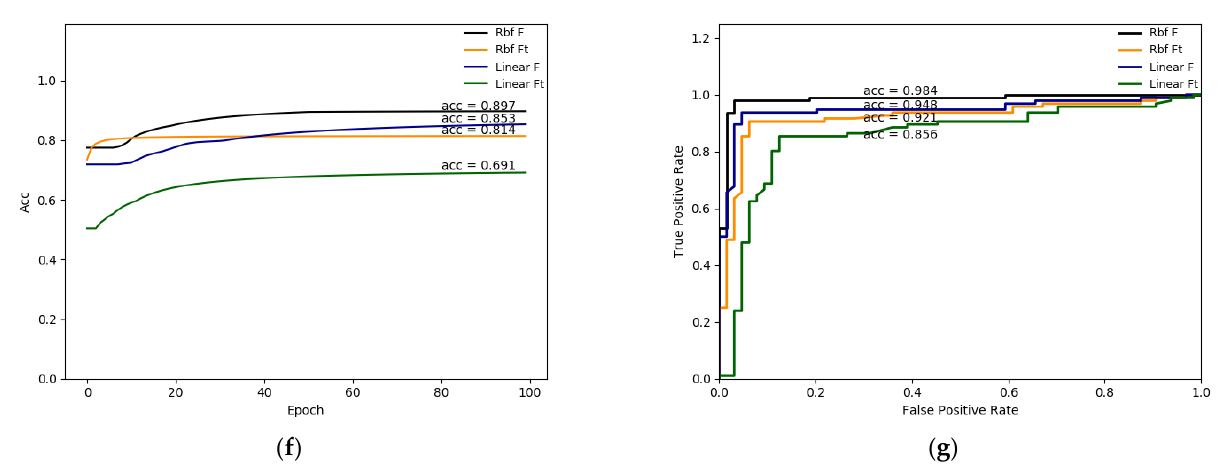
Figure 7. The principle of feature extraction and classification: ( a ) the normal pulse and its wavelet component; ( b ) the slippery pulse and its wavelet component; ( c ) extraction of the spatial-temporal features; ( d ) extraction of the modal energy features; ( e ) classification process of pulse signals; ( f ) classification performance of NN; ( g ) classification performance of SVM.